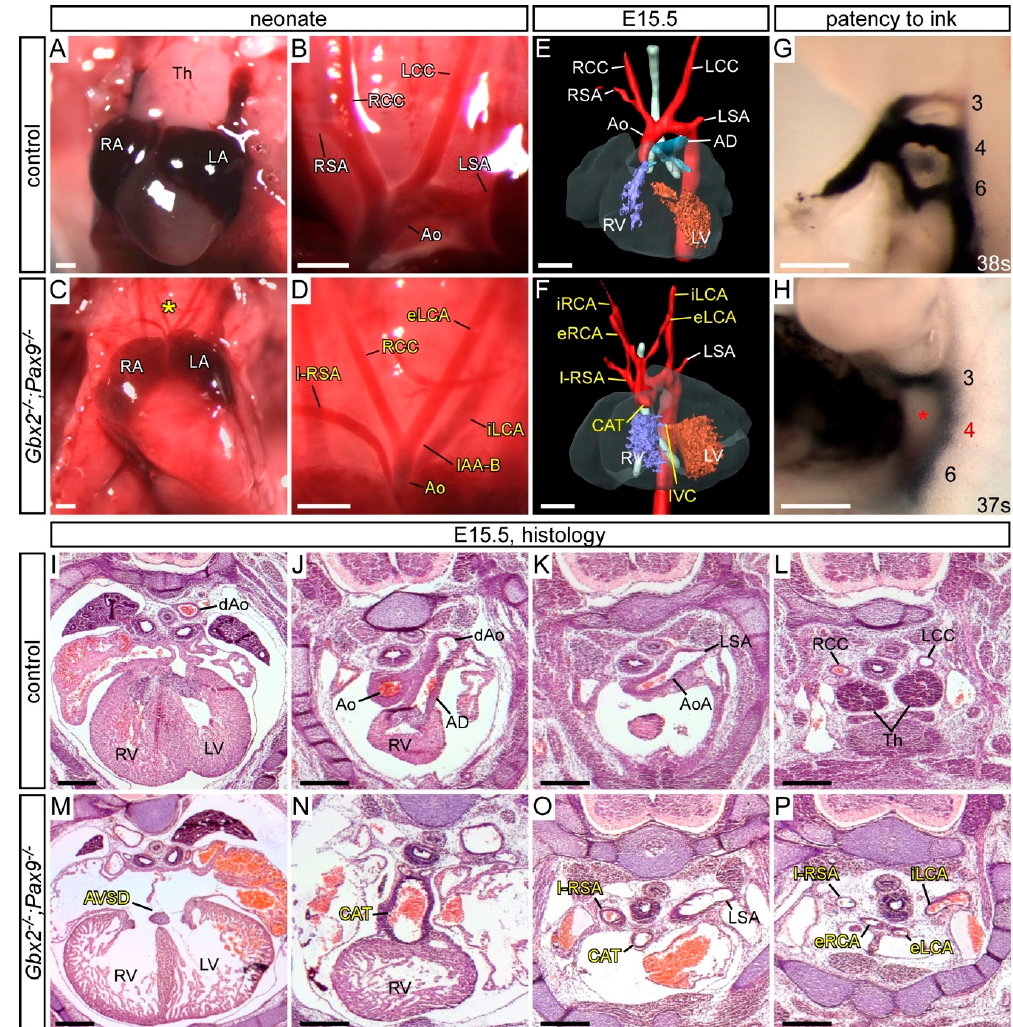
Figure 6. Cardiovascular defects in the three Gbx2 − / − ;Pax9 − / − mutants recovered. ( A – D ) Neonates were dissected on the day of birth. The thymus ( A ) and arch arteries ( B ) were normal in controls, but in a Gbx2 − / − ;Pax9 − / − neonate the thymus was absent (asterisk; C ) and the arch arteries were abnormal ( D ) displaying interrupted aortic arch type B (IAA-B), isolated right subclavian artery (I-RSA) and abnormal left carotid arteries (eLCA, iLCA). ( E , F ) 3D reconstructions of E15.5 hearts from MRI datasets. ( E ) Control embryo with normal heart and aortic arch arteries. ( F ) Gbx2 − / − ;Pax9 − / − embryo with IAA-B, I-RSA, common arterial trunk (CAT) with interventricular communication (IVC), and aberrant carotid arteries (eLCA, iLCA, eRCA, iRCA). ( G,H ) Embryos at E10.5 were analysed by intracardiac ink injection. ( G ) Control embryos had normal PAAs patent to ink. ( H ) Gbx2 − / − ;Pax9 − / − embryo with a non-patent 4th PAA (asterisk). ( I – P ) H&E stained transverse sections of E15.5 embryos. ( I – L ) Control embryo with normal heart ( I ), outflow tract ( J ), aortic arch arteries ( K , L ) and thymus (Th; L ). ( M – P ) Sections from